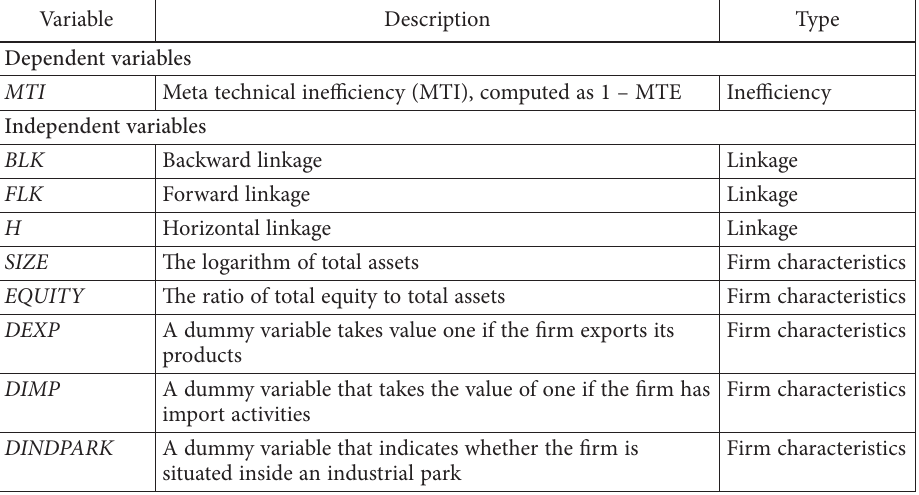
Table 1. Definition of